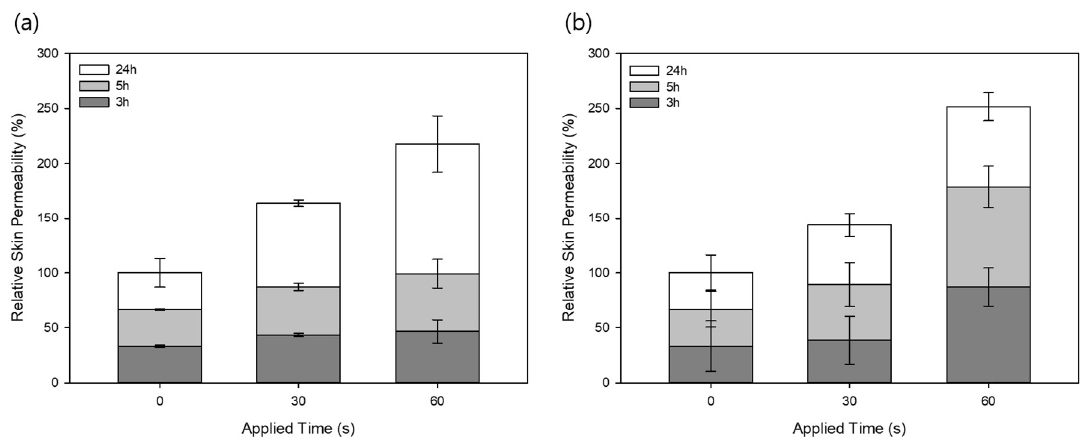
Figure 5. Relative skin permeability of ( a ) sulforhodamine B (SRB) and ( b ) fluorescein sodium salt ± SD, n = (FSS) after applying 1200 MLPs for 30 and 60 s (means ± SD, n = 3). (FSS) after applying 1200 MLPs for 30 and 60 s (means